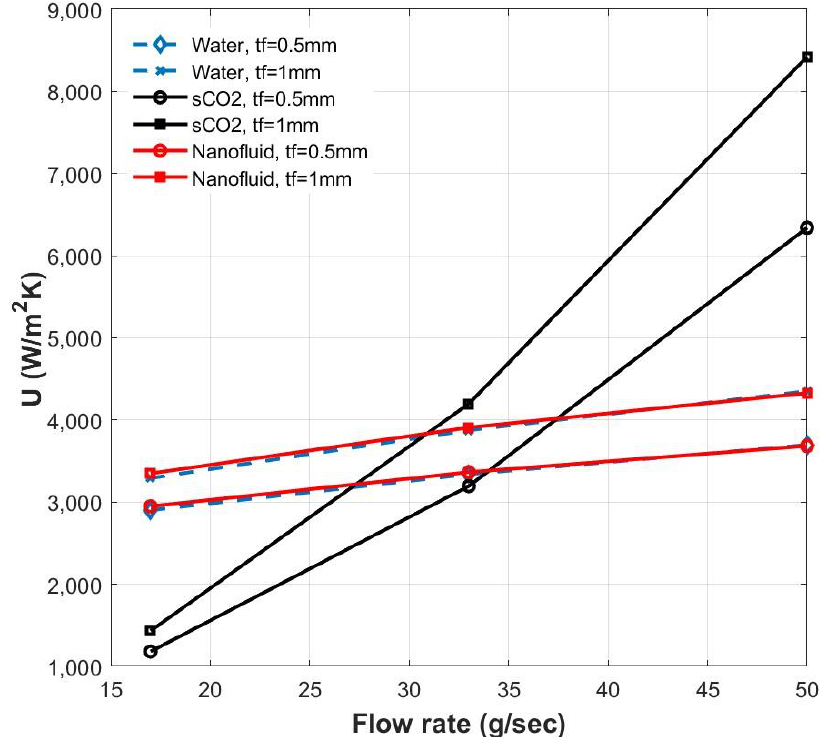
Figure 6. Overall heat transfer coefficient at different flowrates corresponding to different coolants and fin thicknesses.